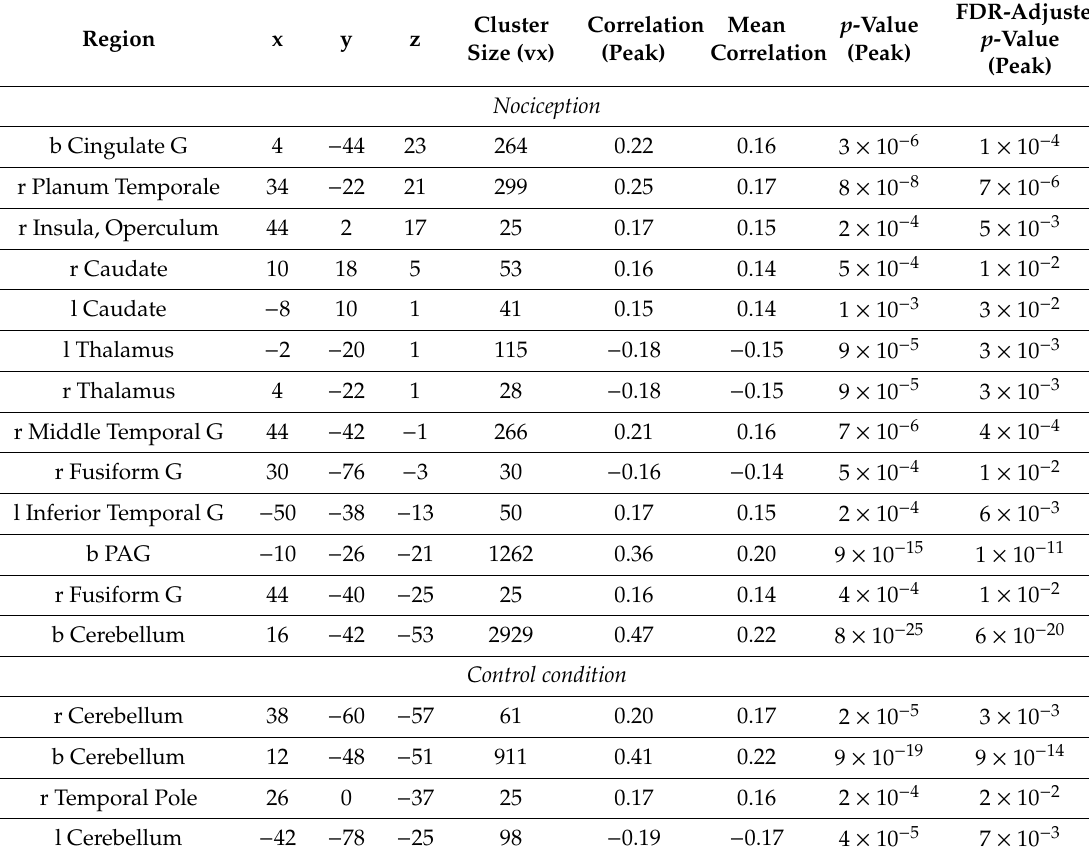
Table 2. Results for the Partial Similarity analysis during trigeminal nociception (gaseous ammonia) and control condition (air pu ff s) at a statistical threshold of FDR-adjusted p < 0.05 and a minimum cluster extent of 20 voxel (160 mL). Coordinates are presented in MNI